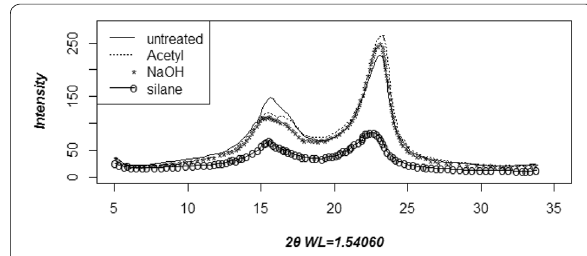
Fig. 4 XRD diffractograms of the hemp fibers.